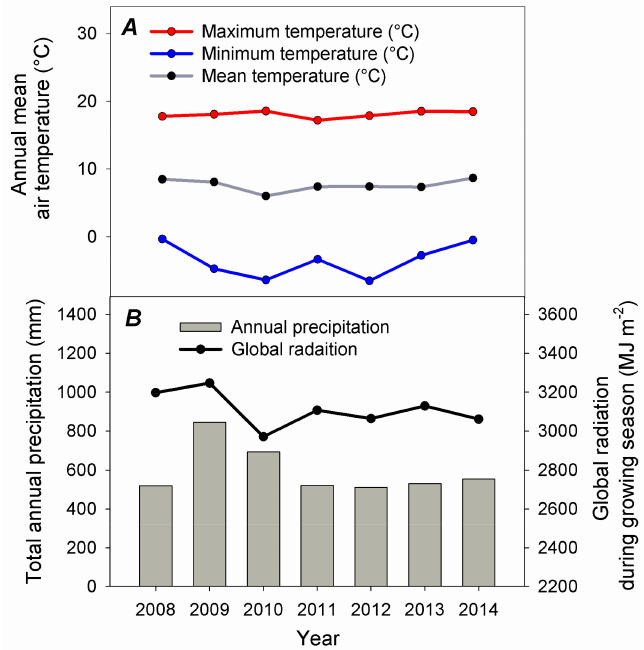
Figure 1. ( A ) The air temperature ( ◦ C; maximum, minimum, and mean) and ( B ) the total amount of annual precipitation (mm) and the total sum of incident global radiation (MJ m − 2 ) per growing season (April–October) from 2008–2014 at the research site Doman í nek, Czech